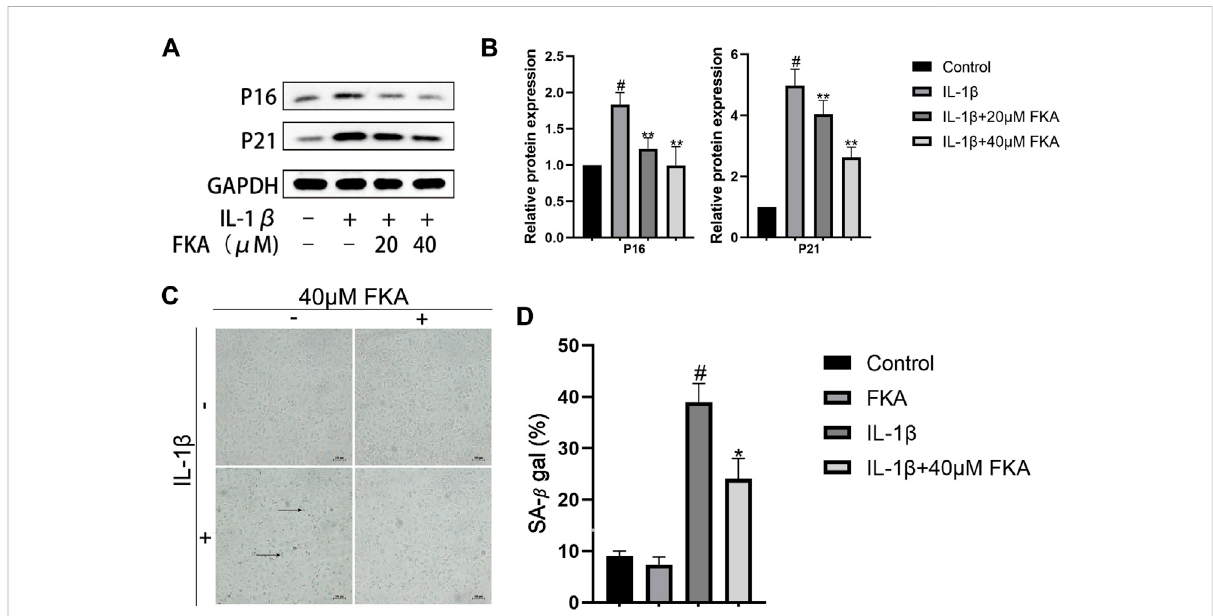
FIGURE 3 The regulation of FKA on the expression of senescence-related genes in chondrocytes (A) Western blot analysis revealing P16 and P21 expression in chondrocytes. (B) Quantitative analysis of protein expression (C) . β -Galactosidase used for the staining of chondrocyte cells